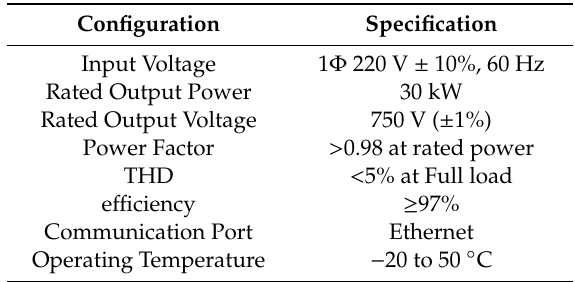
Table 4. AC / DC power converter